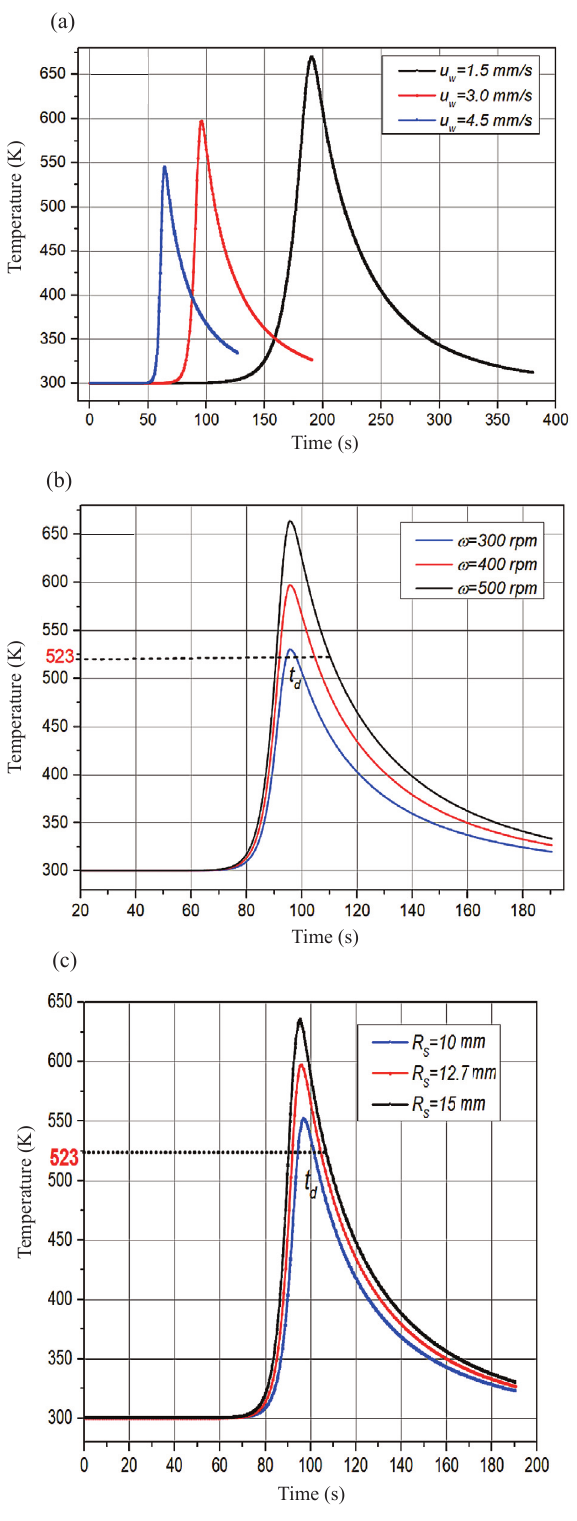
Fig. 6. Effect of the welding parameters: (a) welding speed, (b) rotational speed of the tool and (c) diameter of the tool shoulder on thermal cycles at point P 1 ( x = 305 mm, y = 12.7 mm, z = 2 mm )